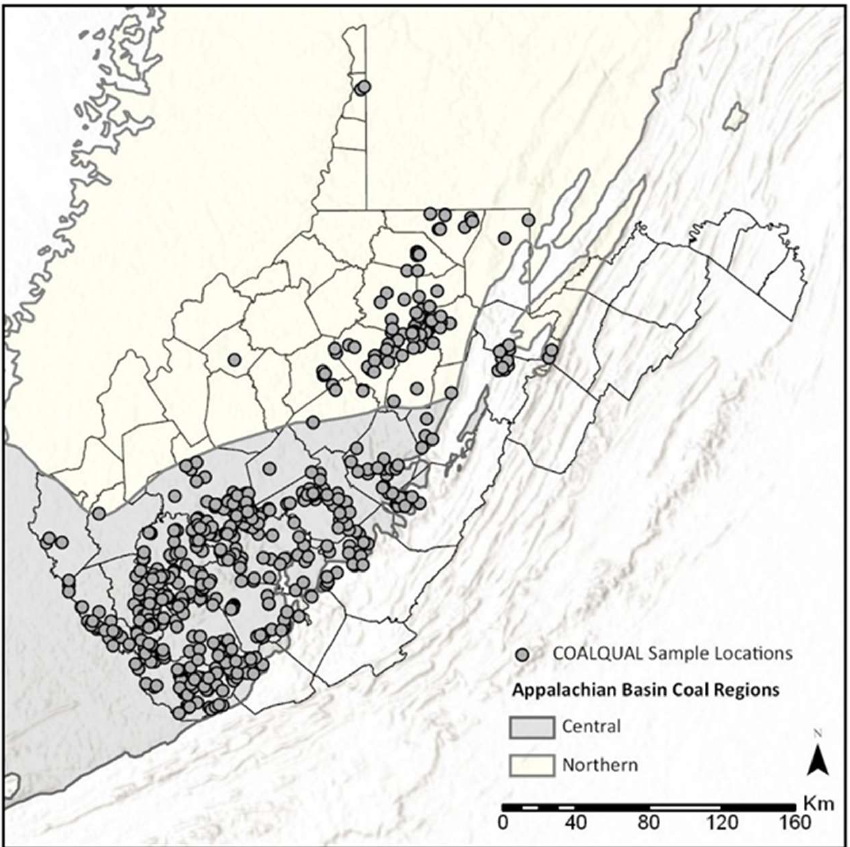
Figure 1. West Virginia (WV) COALQUAL sample locations.